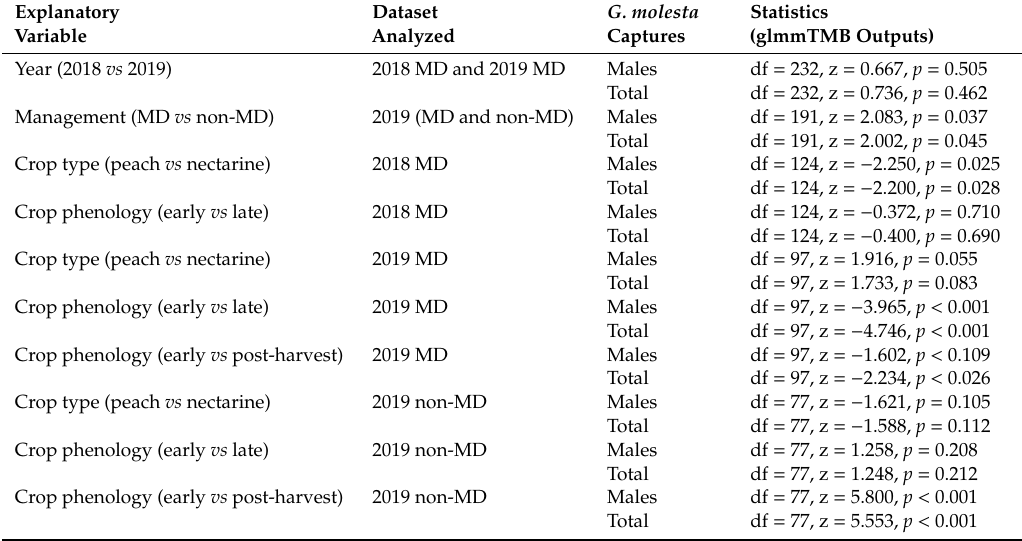
Table 4. Summarized outputs of the statistical analyses performed with a Generalized Linear Mixed Models using Template Model Builder (glmmTMB) to evaluate the e ff ect of the year, Mating Disruption (MD) management, crop type (peach and nectarine) and crop phenology during trial execution (early fruit development, late fruit development and post-harvest) on Grapholita molesta captures in lure comparison trials (n = 33).